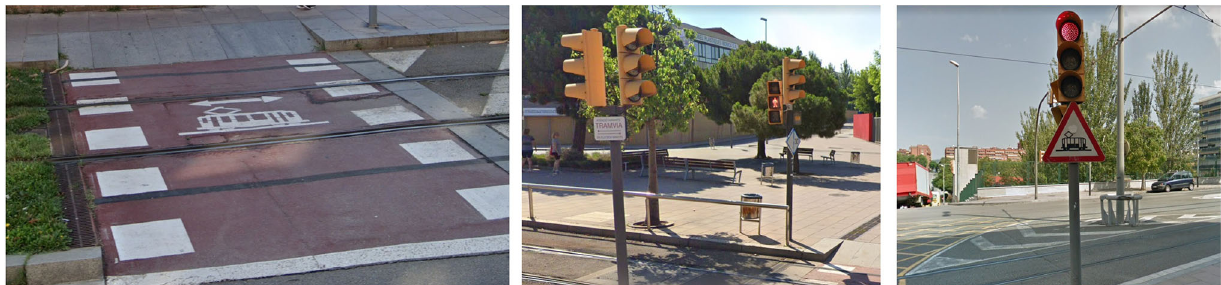
Fig. 4 Horizontal and vertical sign systems—Barcelona Spain - source from Google Earth (data provider: (cid:2) 2020 Google)